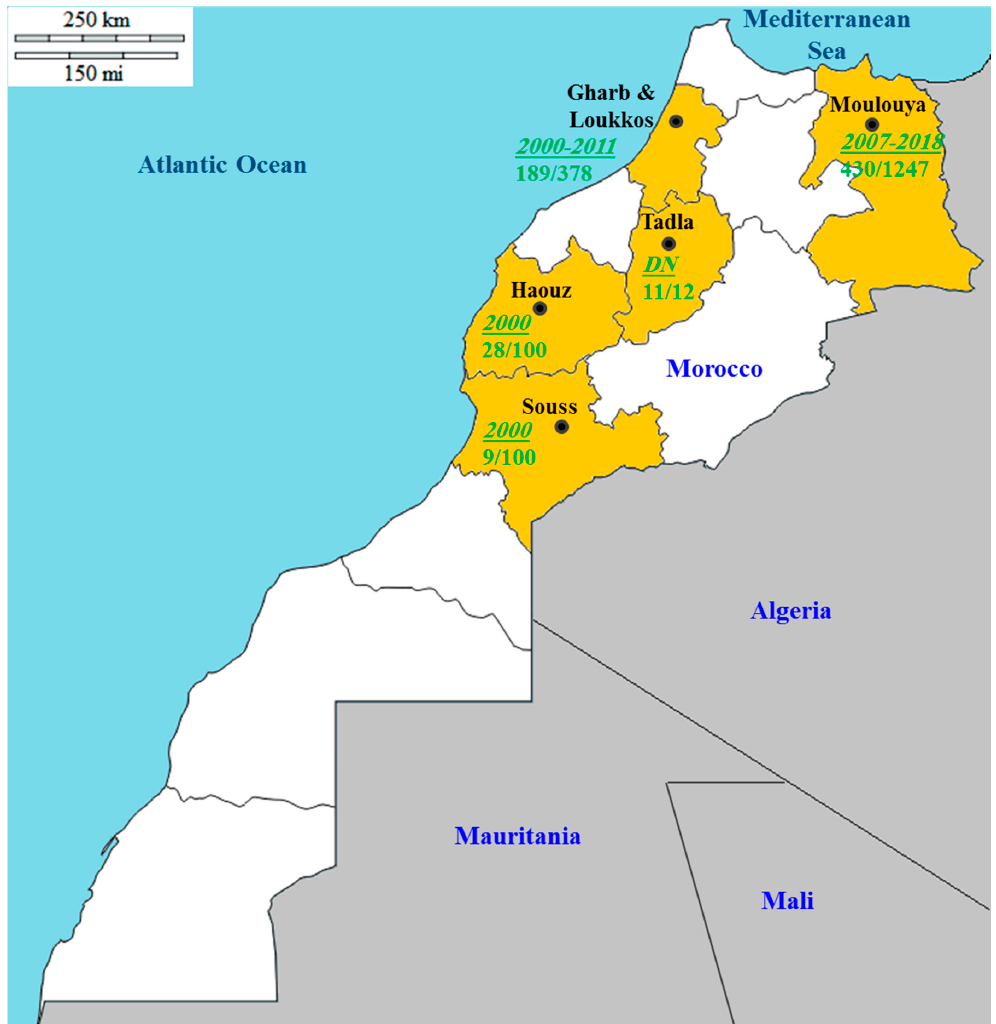
Figure 3. Map of Morocco showing the five regions (highlighted in orange) in which field surveys have been carried out in the main citrus-growing areas to monitor CPsV spread. The green numbers correspond to the years of sampling (italic and underlined) and the number of positive samples to the total collected per area. DN: data not shown.